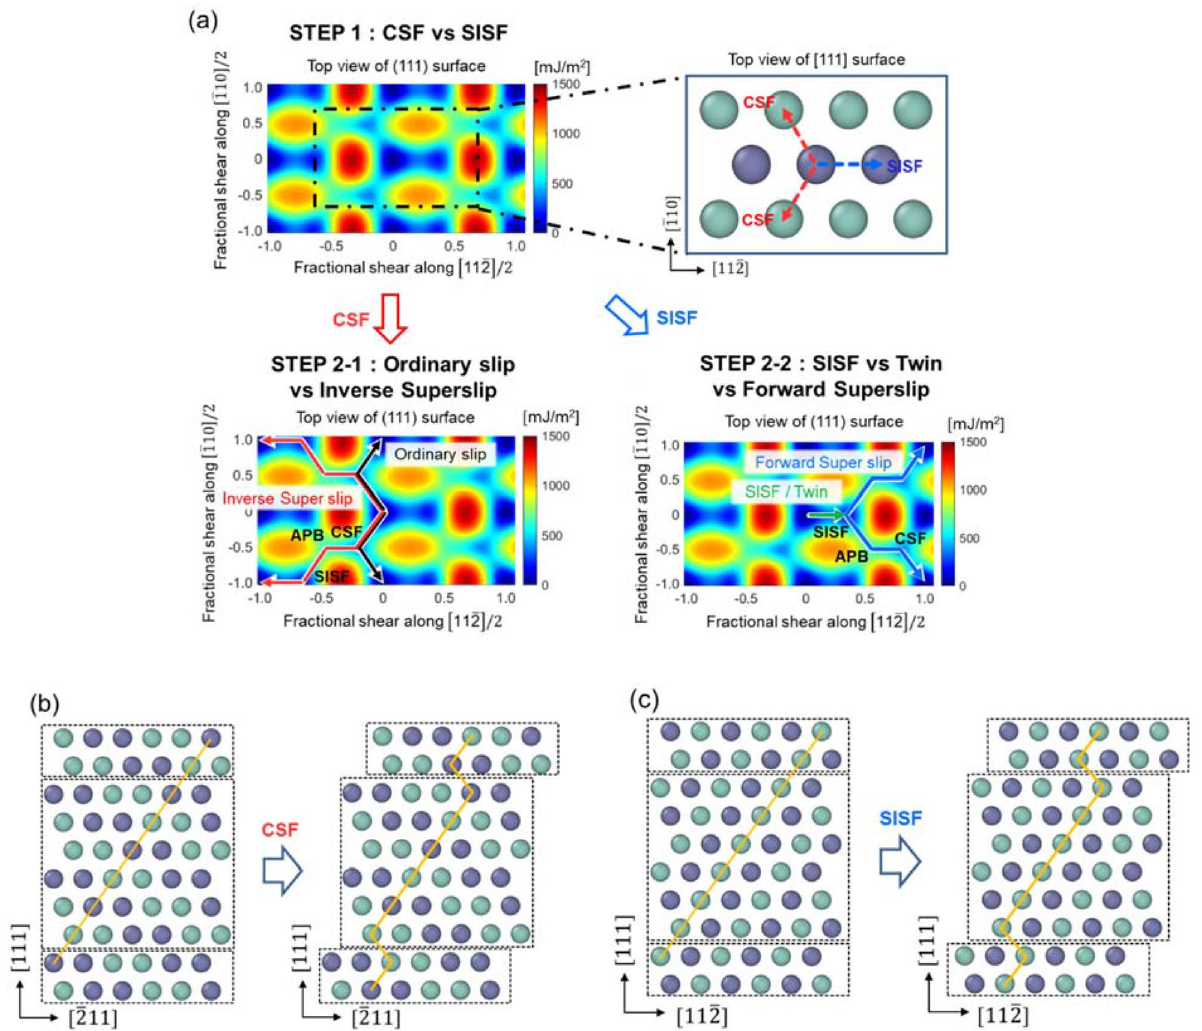
Figure 2. (a) Schematic of the configurations of the five deformation mechanisms in gamma TiAl. (b) Lateral view of CSF partial slip, and (c) lateral view of SISF partial